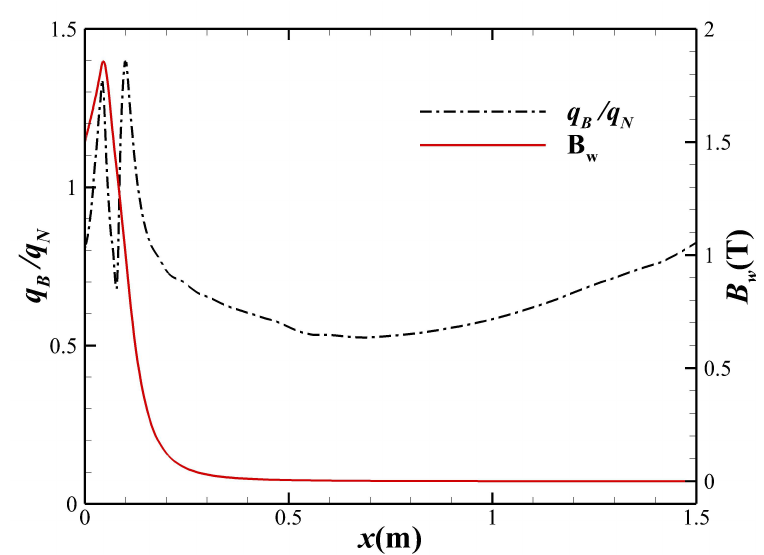
Figure 21. The total magnetic field intensity and relative heat flux distribution along the